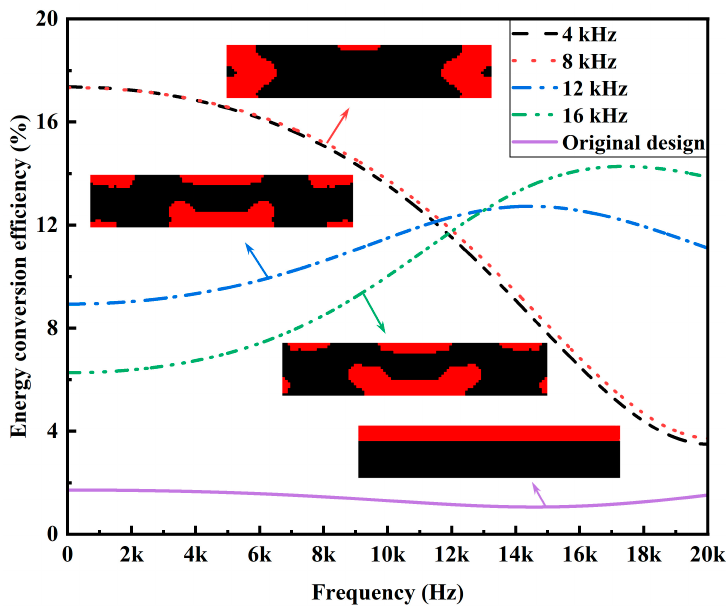
Figure 5. Frequency responses of the energy conversion efficiencies of the enhanced designs.